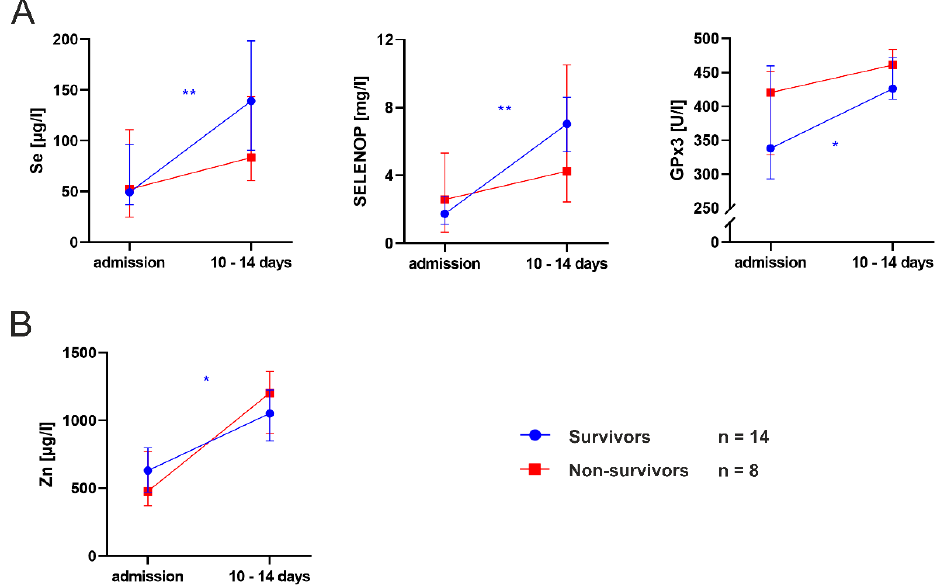
Figure 5. Effects of trace element supplementation on ( A ) selenium (Se) and ( B ) zinc (Zn) concentrations in survivors and non-survivors. Wilcoxon’s paired test was used to compare micronutrient levels between admission and day 10 to 14. p < 0.05 (*), p < 0.01 (**). GPx3, glutathione peroxidase 3;